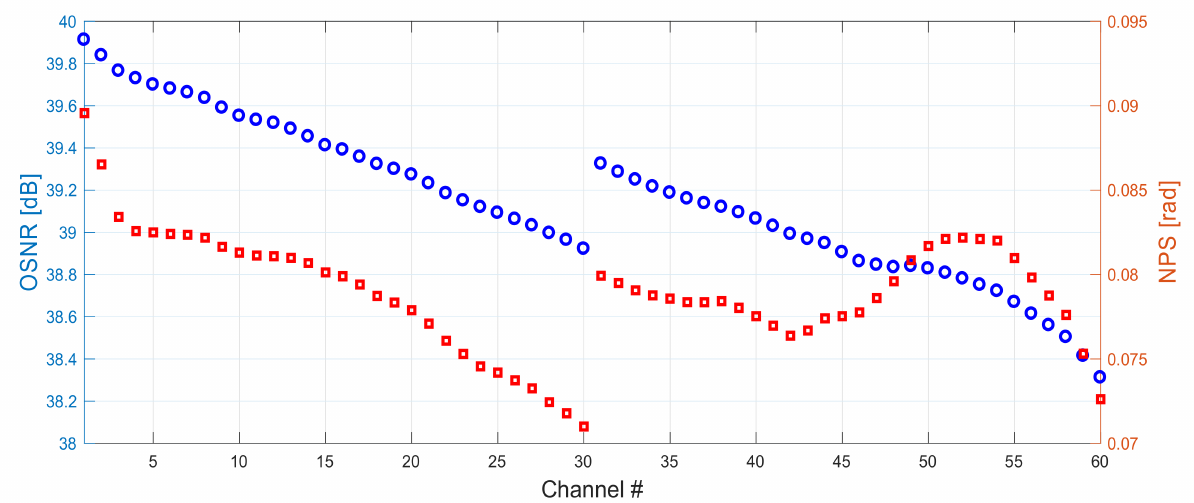
Figure 13. OSNR (blue) and NPS (red) simulations for original (CH1–CH30) and conjugated (CH31–CH60)